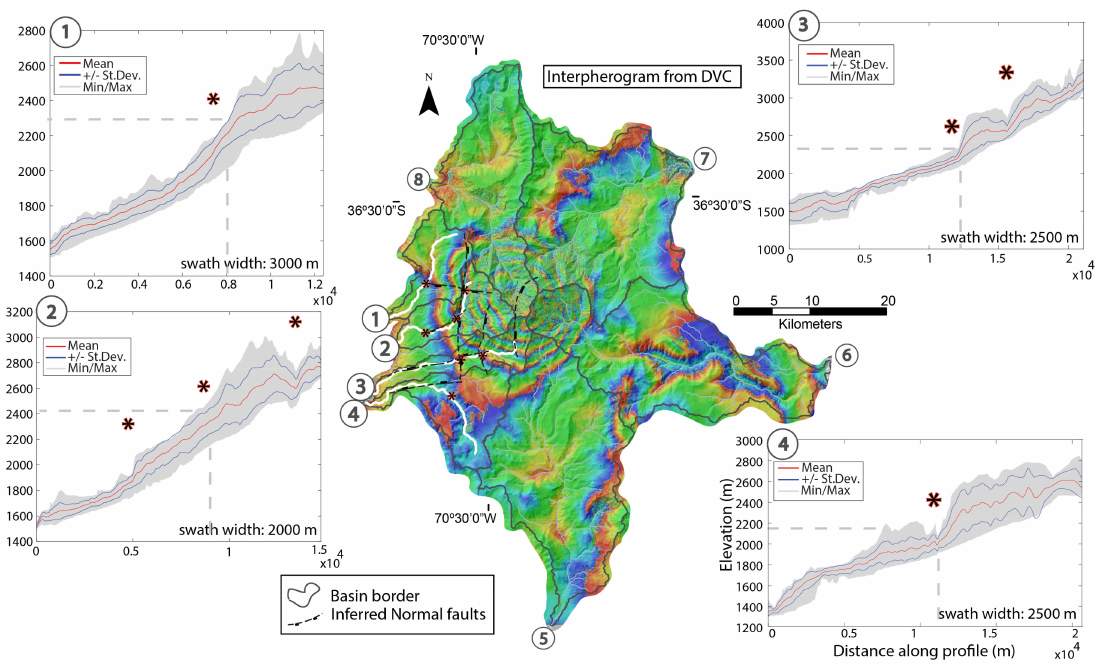
Figure 12. Digital elevation model of the DVC showing the deformation pattern from the InSAR data and the fluvial network with the watershed boundaries shown as gray lines (1–8). Topographic swath profiles 1–4 of the main trunks of the basins draining the western slope of the DVC are marked in white on the map. Red stars over the swath profiles represent changes in the topography of the trunk valleys, indicating changes in relief that nucleate through the first two fringes derived from the InSAR products (the abscissa axis of the swath profiles starts downstream and goes up to the